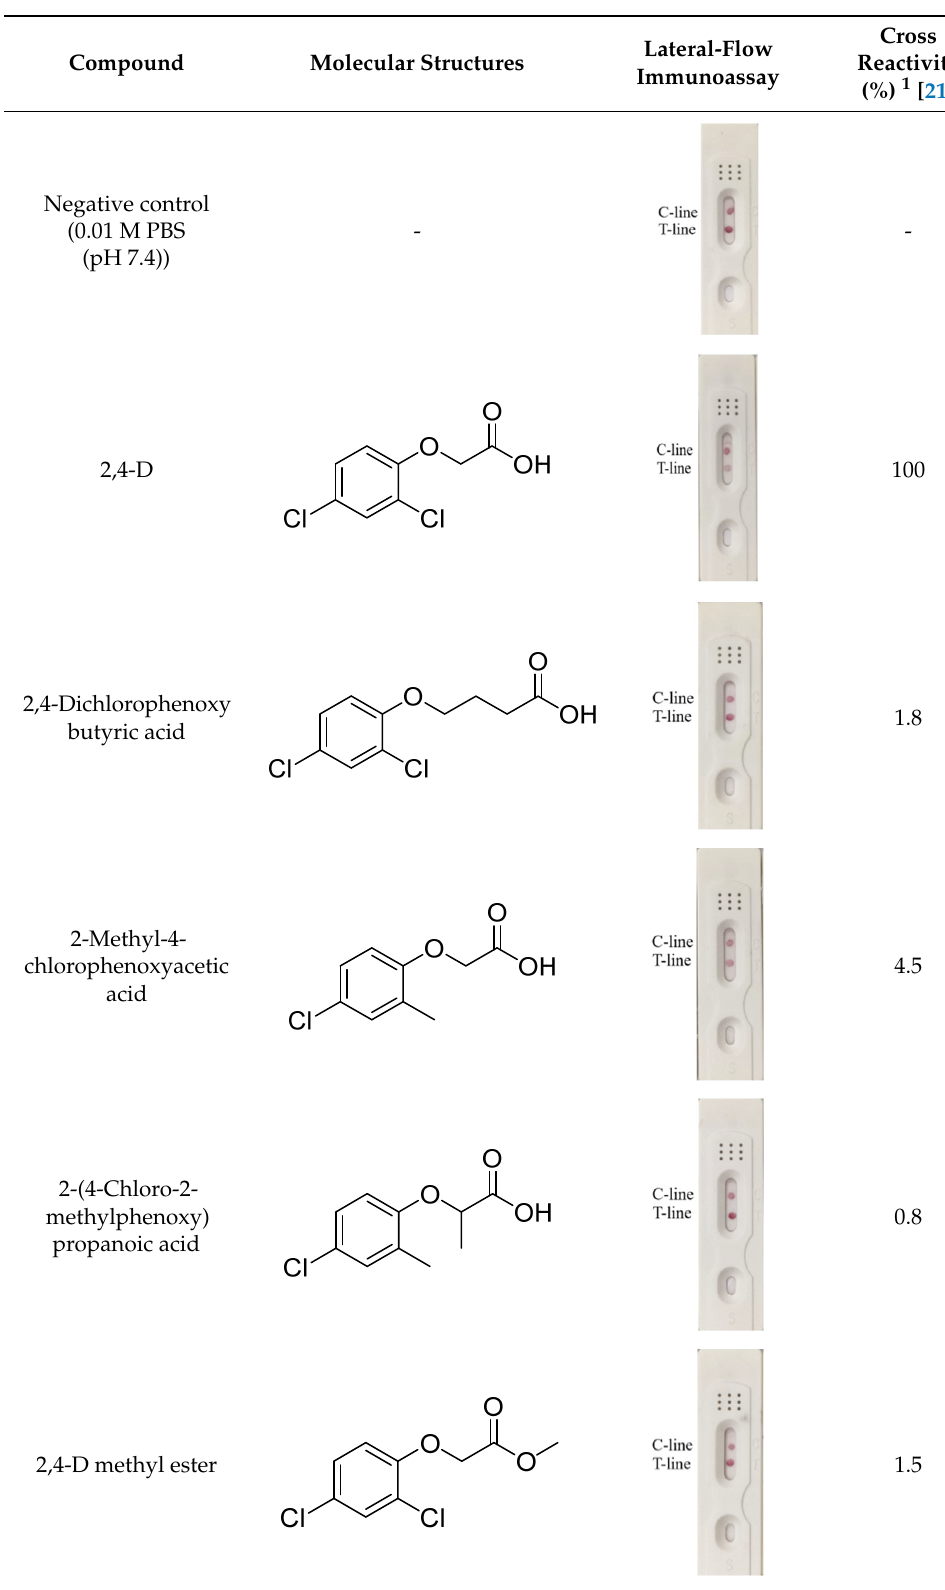
Table 1. Cross-reactivity of the developed test strips against 2,4-D structural analogs. Compound Molecular Structures